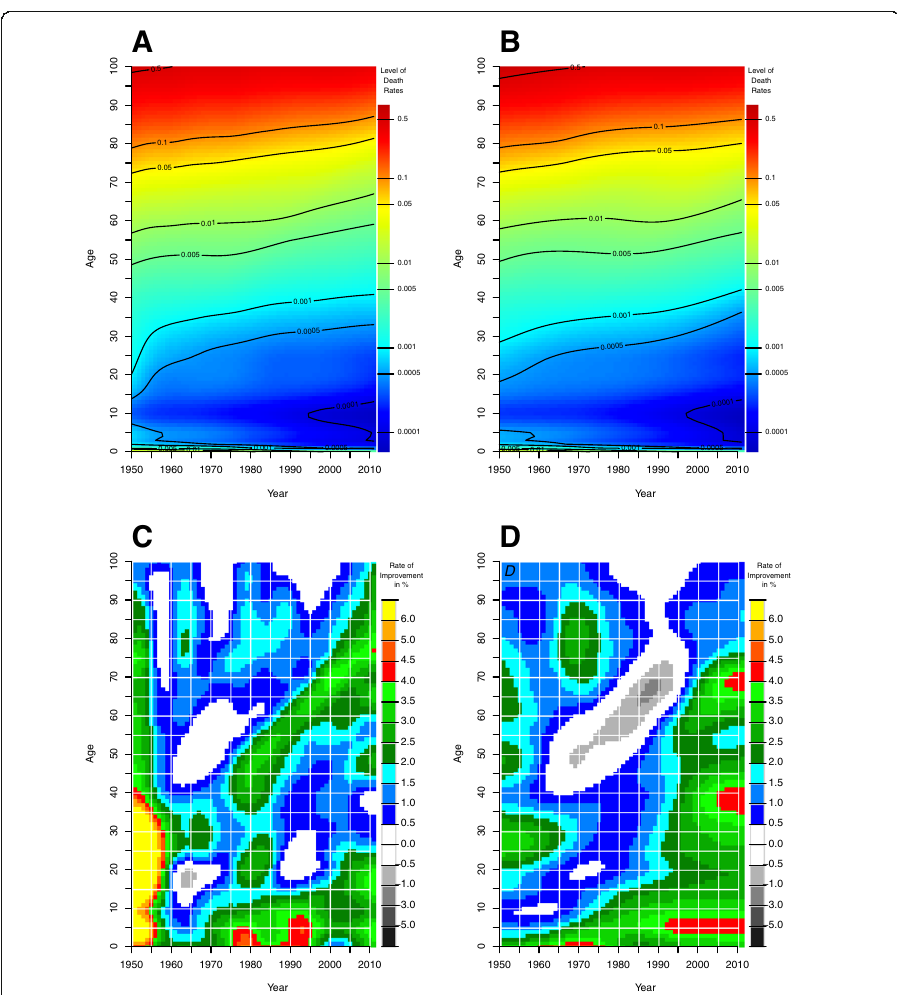
Fig. 1 Input of our model. Upper panel : (smoothed) death rates for women in the UK ( a ) and Denmark ( b ). Lower panel : rates of mortality improvement (in %) for women in the UK ( c ) and Denmark ( d ). Source: Authors ’ estimations based on data from the Human Mortality Database